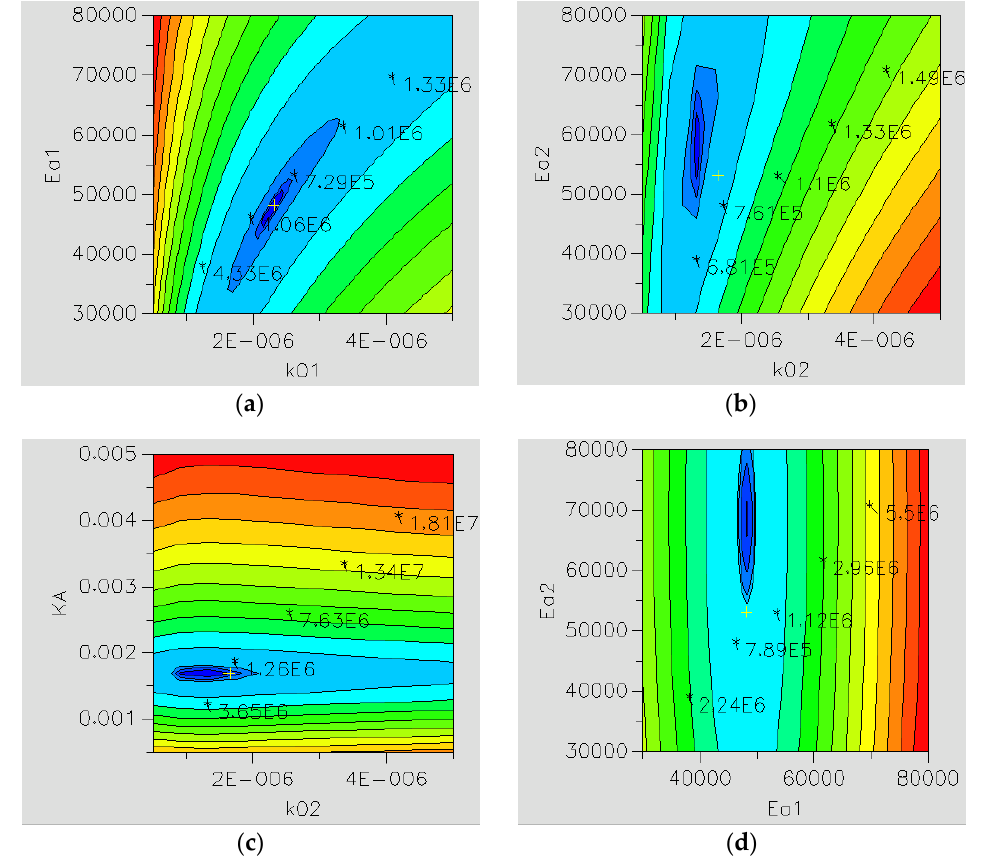
Figure 3. Value of the objective function versus ( a ) activation energy and pre-exponential factor of galactose hydrogenation, ( b ) activation energy and the pre-exponential factor of arabinose hydro- genation, ( c ) arabinose adsorption equilibrium constant and the pre-exponential factor of arabinose hydrogenation, and ( d ) both activation energies. Please note that the depicted pre-exponential factors refer to a reference temperature and, therefore, have different values.